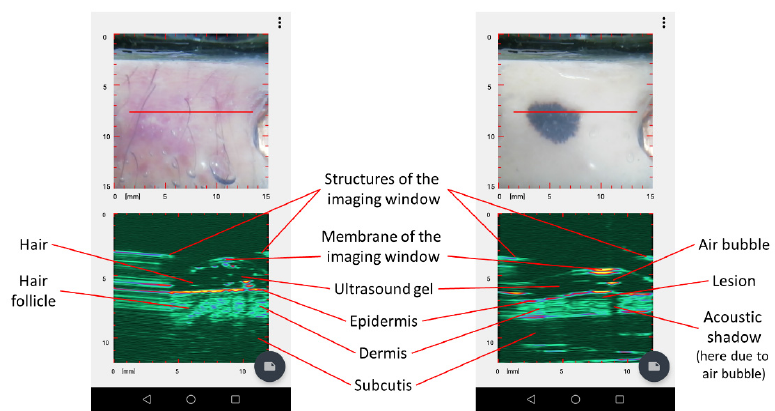
Figure 3. Typical elements of the ultrasound images of the Dermus SkinScanner . Ultrasound reflections from skin structures outline layers such as the epidermis, dermis and subcutis, and also other structures including lesions or hair follicles. These structures are preceded by reflections from the membrane and other structures of the imaging window of the device itself. The ultrasound gel fill- ing the volume in between the imaging window membrane and the surface of the skin is reflection- free. However, reflections from hair or air bubbles may be present in this region, and they may even cause the appearance of acoustic shadows on the deeper regions of the image.